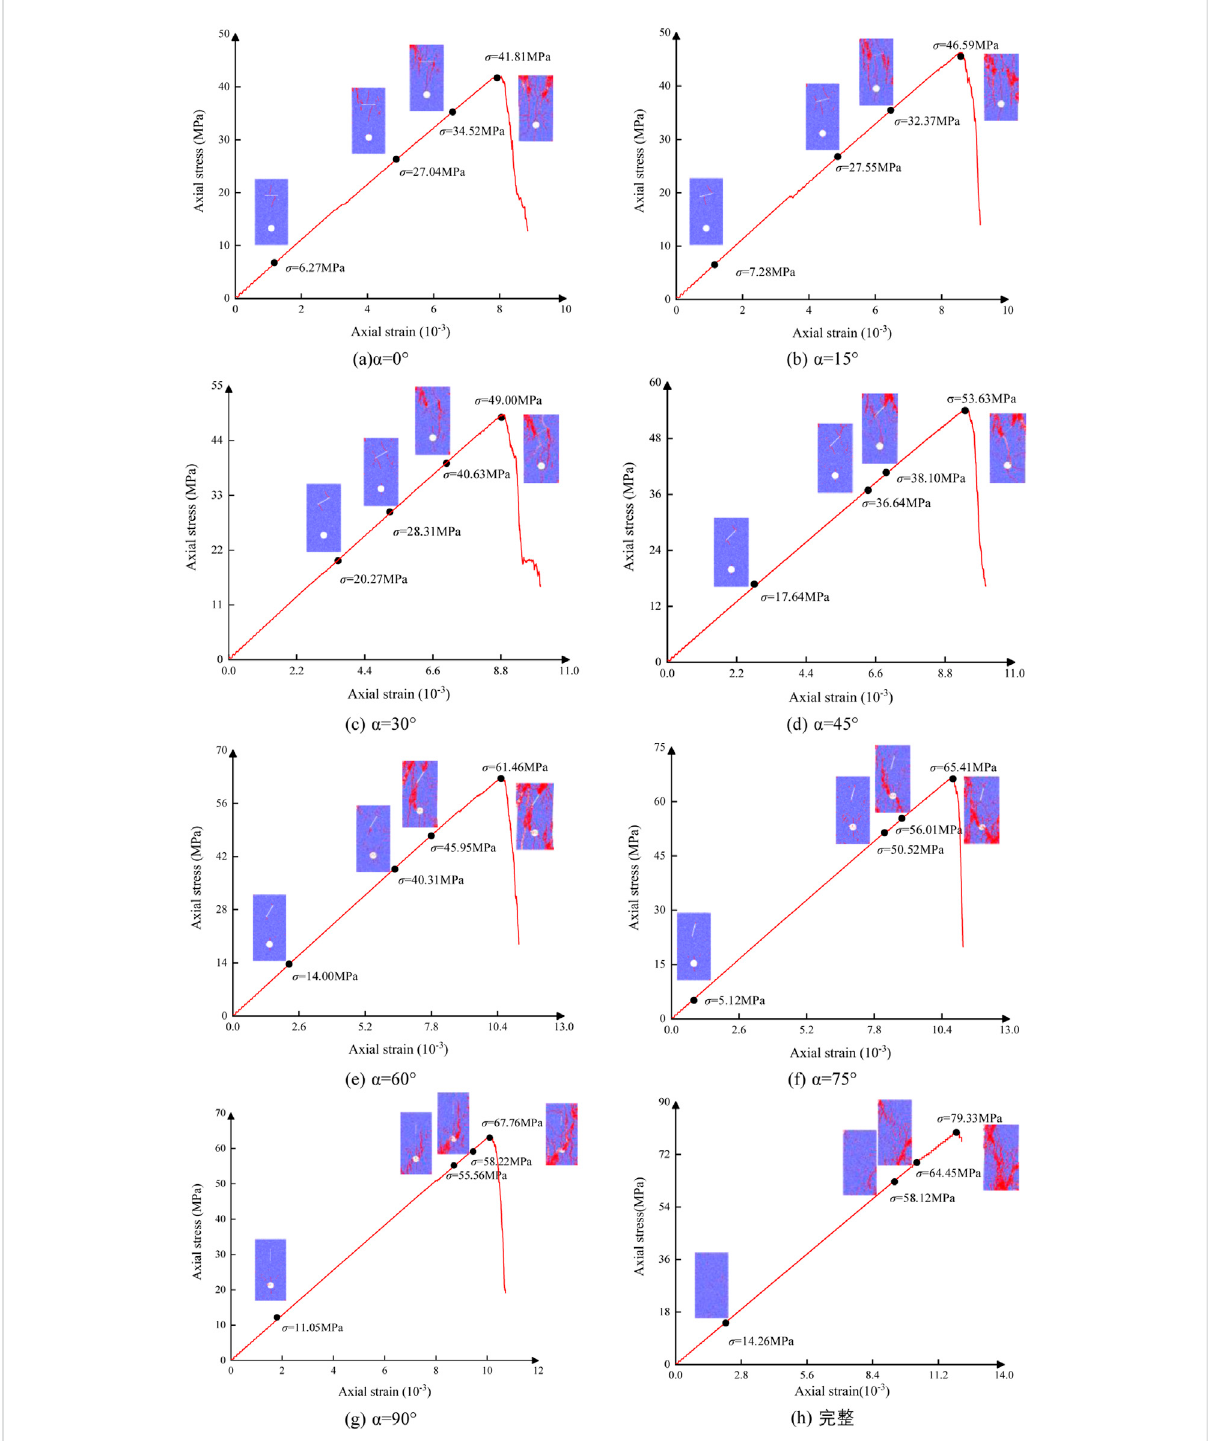
FIGURE 8 Complete rock model and failure mode of single fracture-hole rock model with different fracture angles. (A – H) , the damage mode images of the fracture at 0-90 ° and intact are